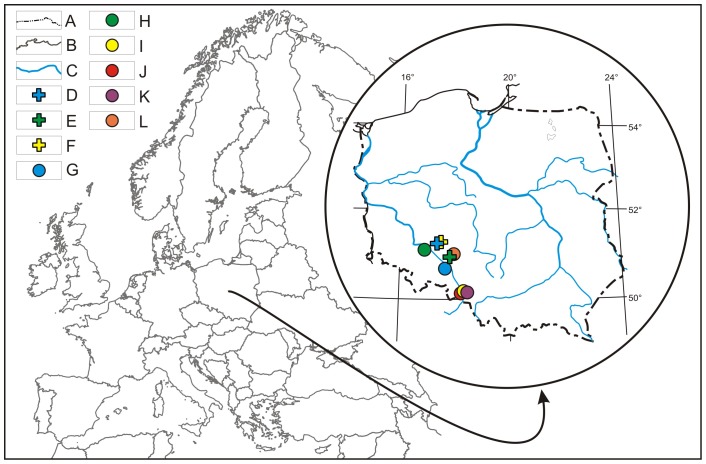
Map showing the distribution of sampling sites.A: border of countries, B: border of Poland, C: main rivers, D–F: sites on organic-mineral soils (blue: 82, 83; yellow: 72, 73, 75; green: 105), G–L: sites on mineral soils (red: 136, 138, 141; yellow: 129, 131; purple: 275, 278, 280; blue: 120, 121; orange: 96, 98, 102; green: 161, 165, 169). Colours indicate the collection number.